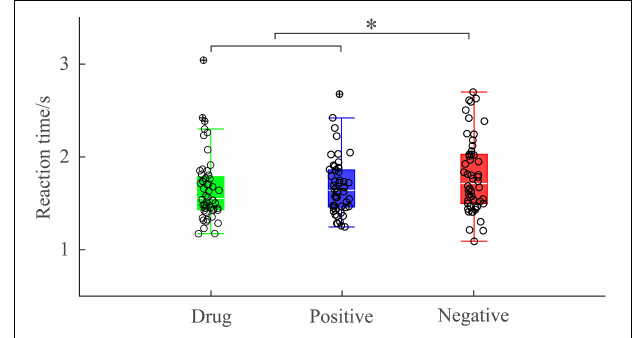
FIGURE 3 | Reaction time under different experimental conditions. ∗ p <